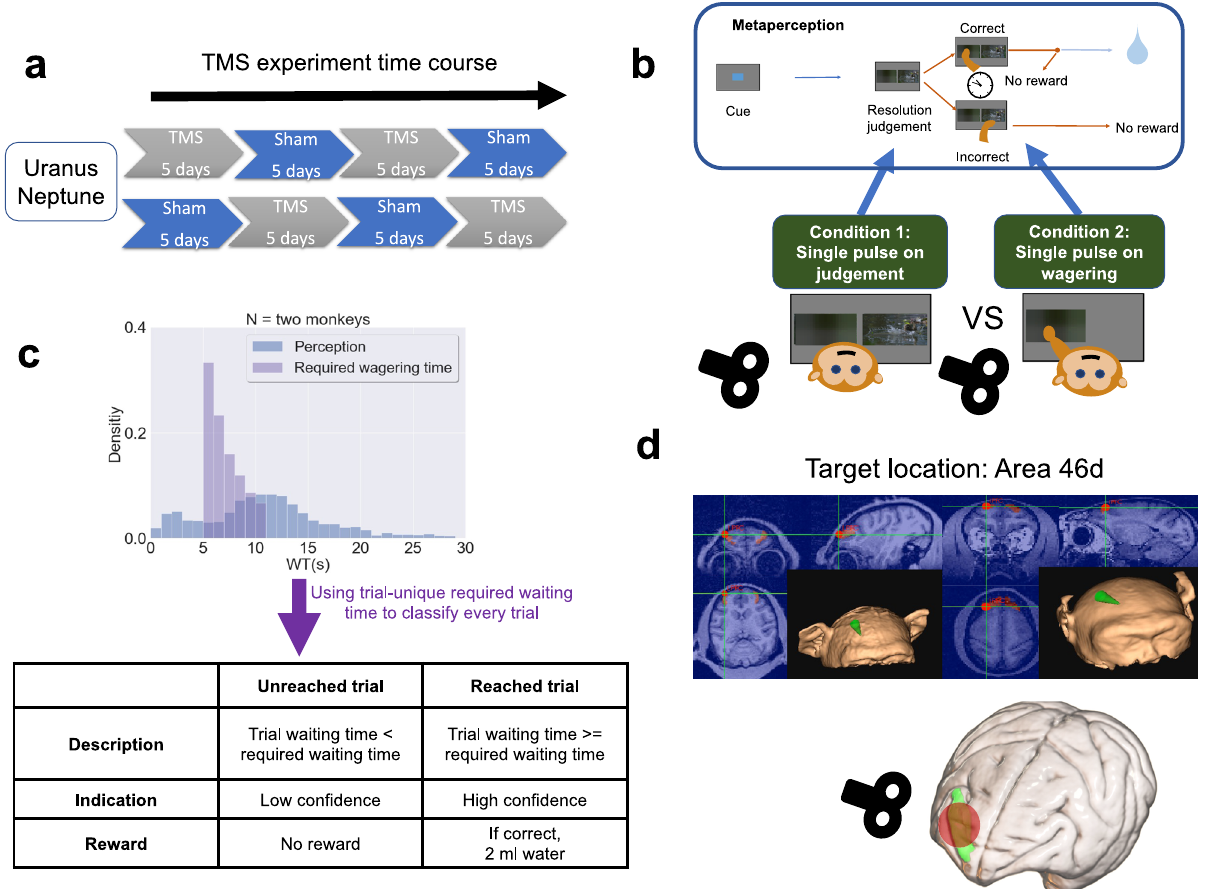
Fig. 7 Temporal structure of the TMS experiment. TMS experiment schedule with TMS-46d/sham conditions counterbalanced between monkeys (Uranus and Neptune) ( a ). Perceptual judgement task with temporal wagering. Each trial consisted of a starting (blue) cue, a delay lasting 1~6 s, and two simultaneously presented pictures. The monkeys needed to choose the picture with lower resolution (or higher resolution, counterbalanced across monkeys) by holding their hand on the touchscreen. The waiting process was initiated as soon as they laid their hand on the picture. Their con fi dence in the decision was measured by temporal wagering; that is, they could wait for a reward if they were con fi dent or opt out to abort the current trial. There were two TMS conditions, which differed in the timing of stimulation. In each trial, the monkeys received a single TMS pulse either immediately after the onset of the picture stimulus (on-judgement phase) or 100 ms after they made their perceptual decision (on-wagering phase) ( b ). The required WT distribution and the actual WT distribution (only catch trials and incorrect trials) with WT bin size set to 1 s. The table depicts the classi fi cation of low-con fi dence trials (unreached trials) and high-con fi dence trials (reached trials) ( c ). An illustration of the TMS site, as indicated by the green arrows. Bottom: The green area indicates BA46d on a rendering of a macaque brain; the red disc indicates the target area ( d